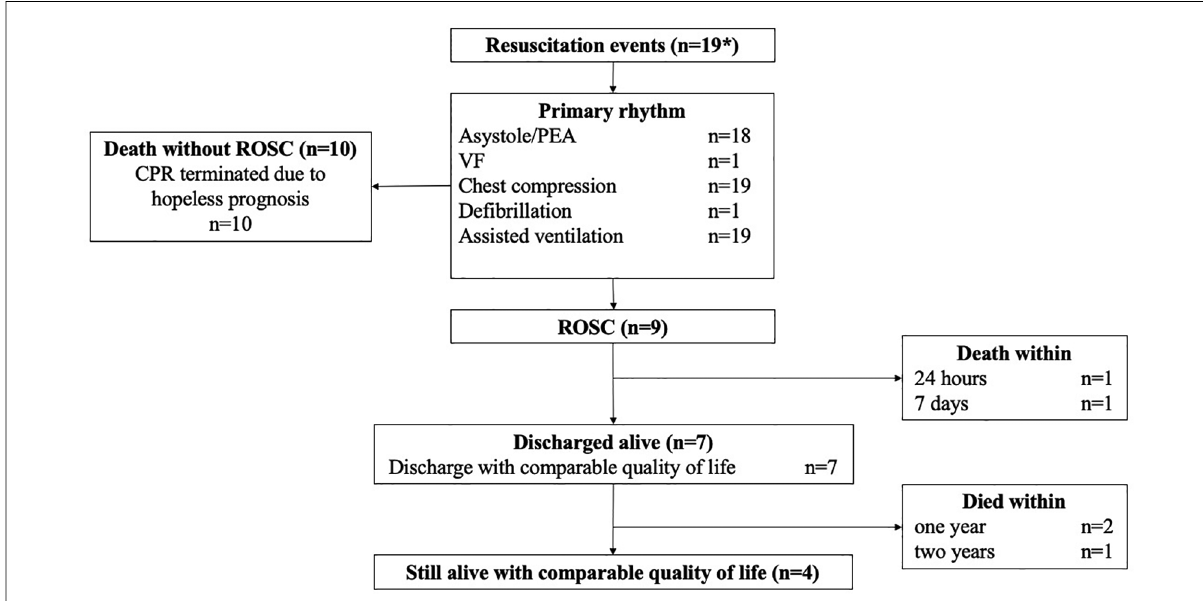
FIGURE 1 Flow chart demonstrating the resuscitation data and survival according to the utstein criteria (10). * sympolizes that 19 resuscitation events occurred in 17 patients (two patients suffered from cardiac arrest twice). Abbreviations: CPR, Cardiopulmonary resuscitation; PEA, Pulseless electrical activity; ROSC, Return of spontaneous circulation; VF, Ventricular fi